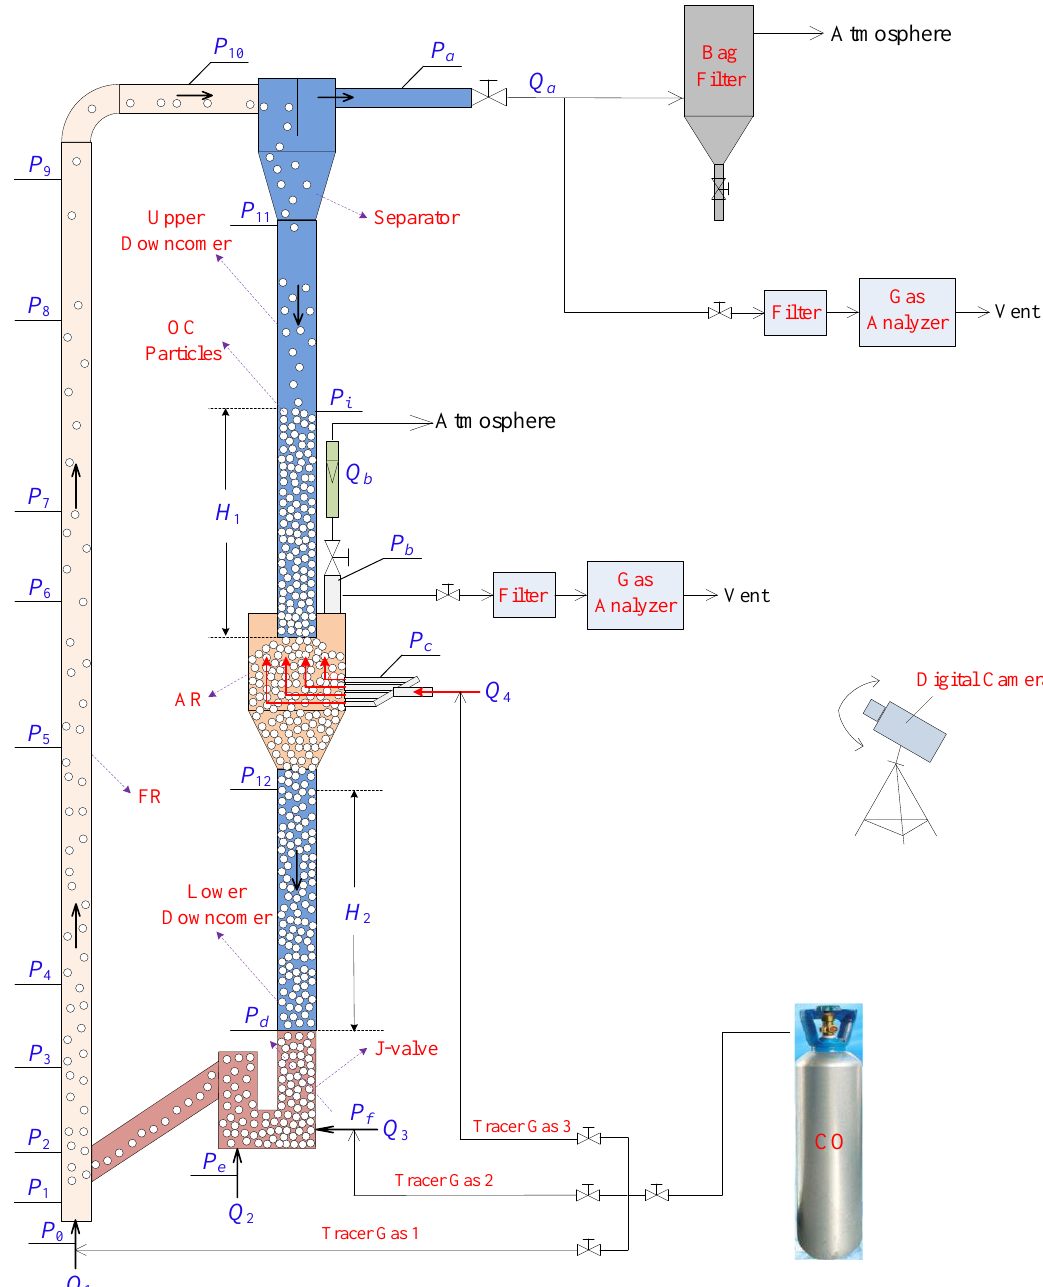
Figure 2. Schematic diagram of the cold-state experimental device of the high-flux CDCLC system. P : pressure; Q : gas flow; AR: air reactor; FR: fuel reactor.